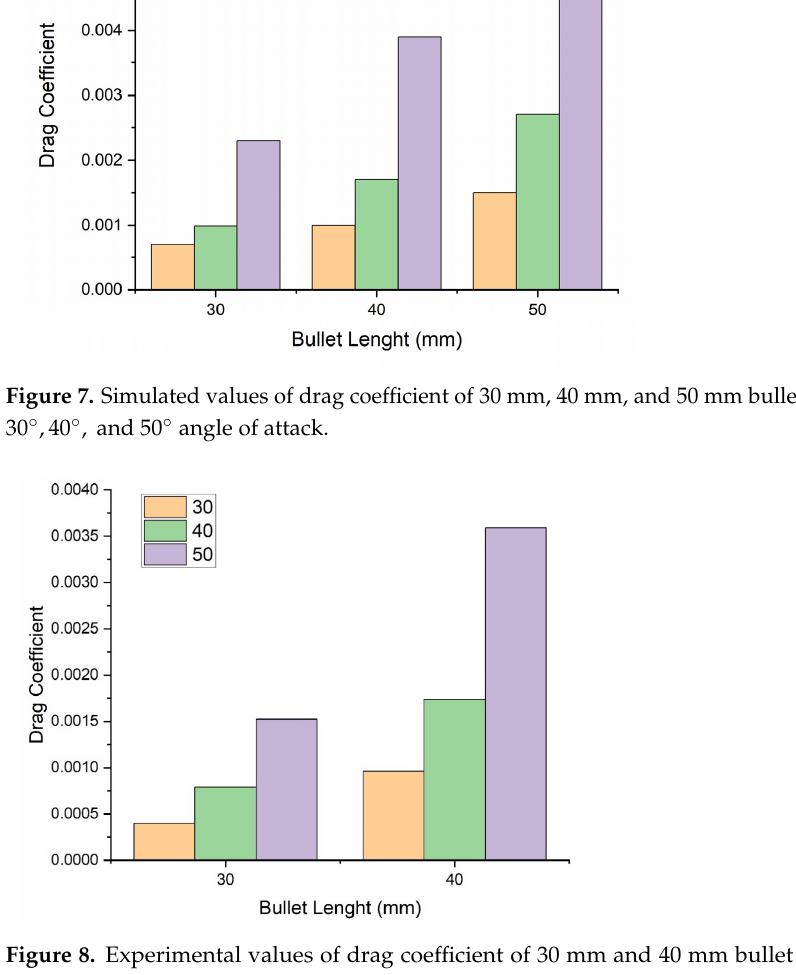
Figure 8. Experimental values of drag coefficient of 30 mm and 40 mm bullet heads (design I) at 30°,40°,and 50° angle of attack. Table 3. Simulated and experimental values of drag coefficient of bullet heads of 30 mm, 40 mm, and 50 mm at varying angles of attack.